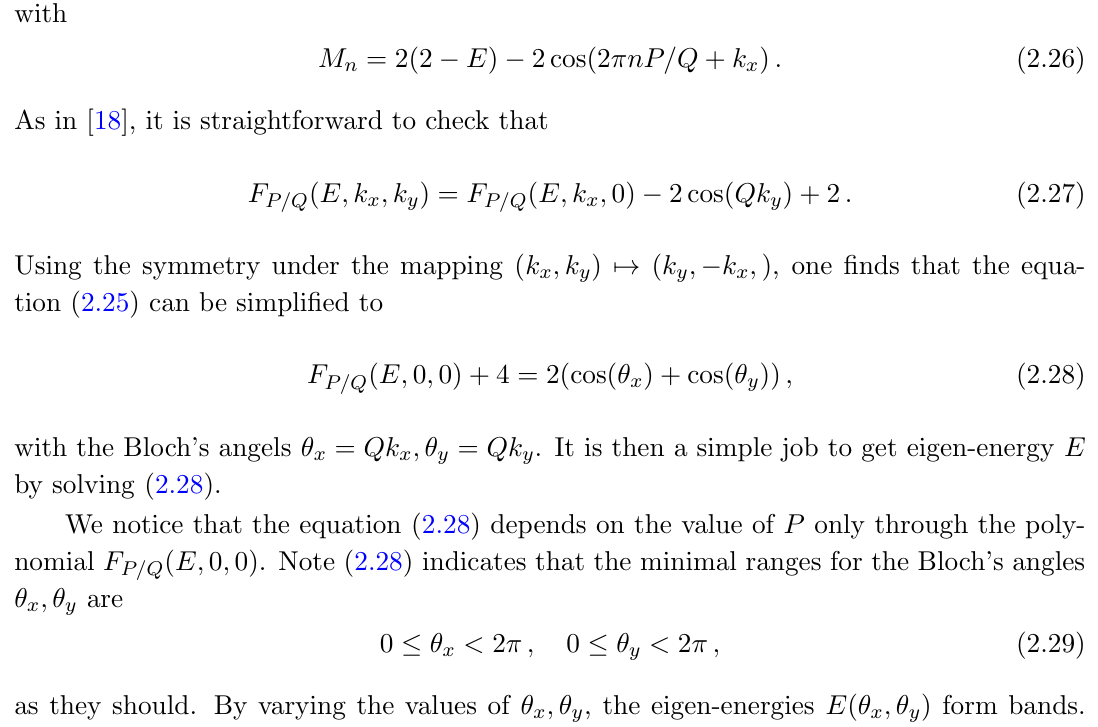
Figure 1. The Hofstadter butter(cid:13)y plots energy levels E k against magnetic (cid:13)ux (cid:30) 2 2 (cid:25) Q for the Harper-Hofstadter model. We take (cid:30)= 2 (cid:25) to be P=Q for any coprime pairs of positive integers such that P (cid:20) Q and Q (cid:20) 30.